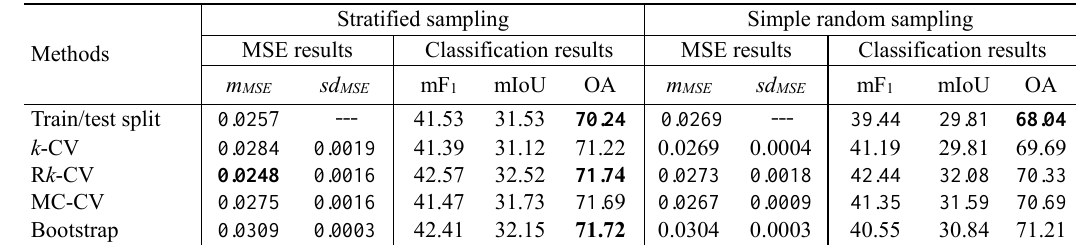
Photogrammetry and Remote Sensing) benchmark Vaihingen